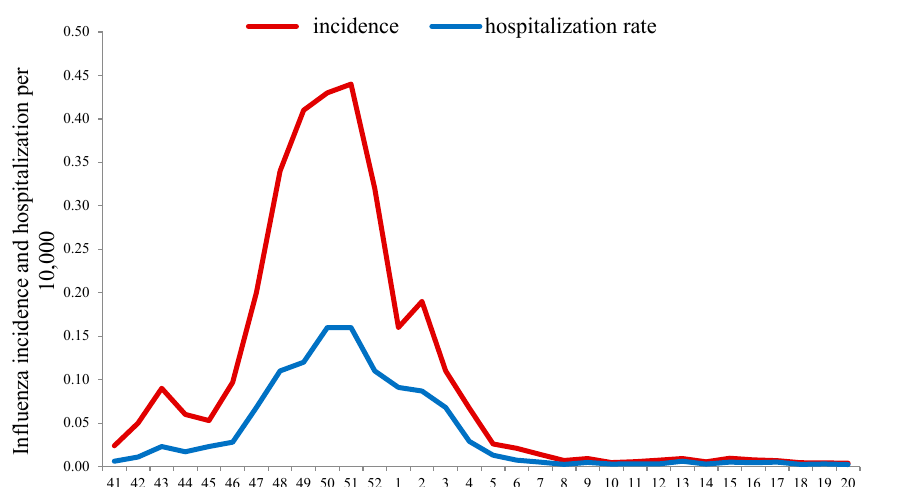
Figure 1. Dynamics of influenza incidence and hospitalization according to clinical diagnosis in the 2021–2022 influenza season in Russia.